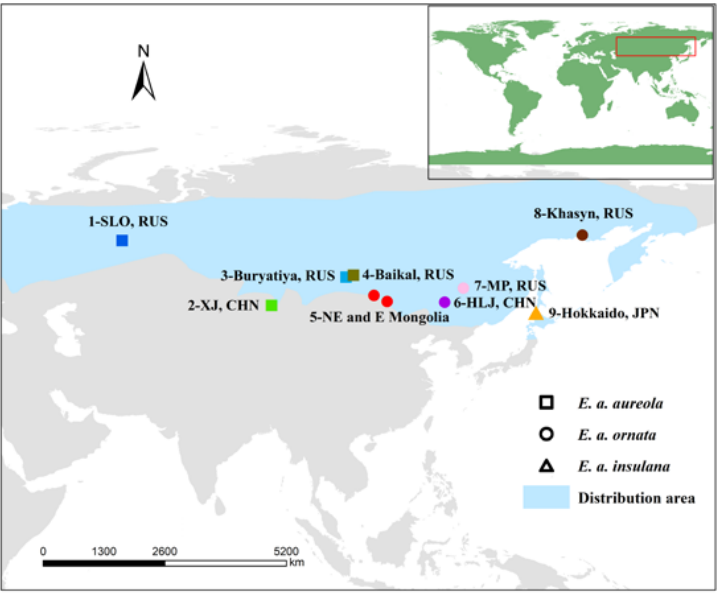
Figure 1. Distribution of Emberiza aureola taxon recordings from nine populations used in the subspecies vocal divergence analysis, with sampling sites indicated by different symbols. Squares represent E. a. aureola (population 1 = Sverdlovsk Oblast, Russia; 2 = Qinghe County, Xinjiang Province, China; 3 = Buryatiya, Russia; 4 = Lake Baikal, Russia), circles represent E. a. ornata (population 5 = northeastern and eastern Mongolia; 6 = Zhalong, Heilongjiang Province, China; 7 = Muraviovka Park, Russian Far East; 8 = Khasyn, Magadanskaya Oblast, Russia), and the triangle represents E. a. insulana (population 9 = Toyotomi, Hokkaido, Japan). Different colors and numbers represent different populations marked in the legend.